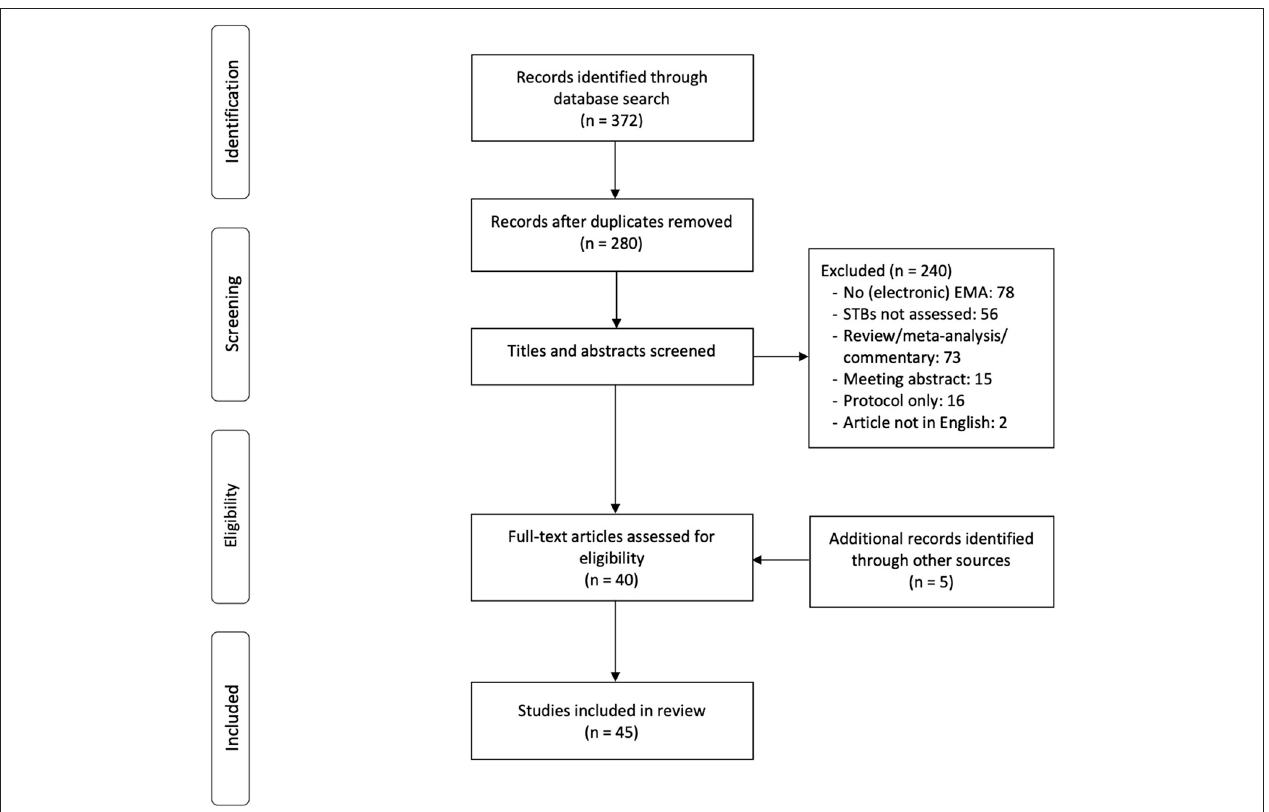
FIGURE 1 | Preferred reporting items for systematic reviews and meta-analyses (PRISMA) flow diagram of included